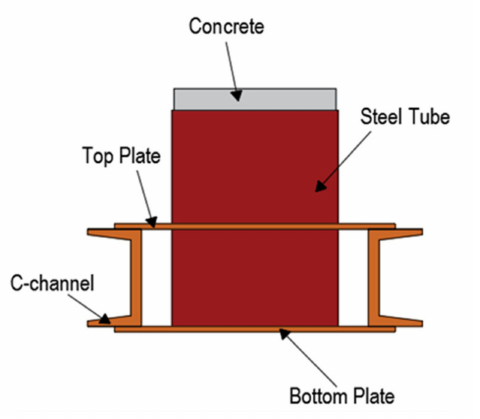
Figure 2. CFST column—details of column-to-foundation beam connection